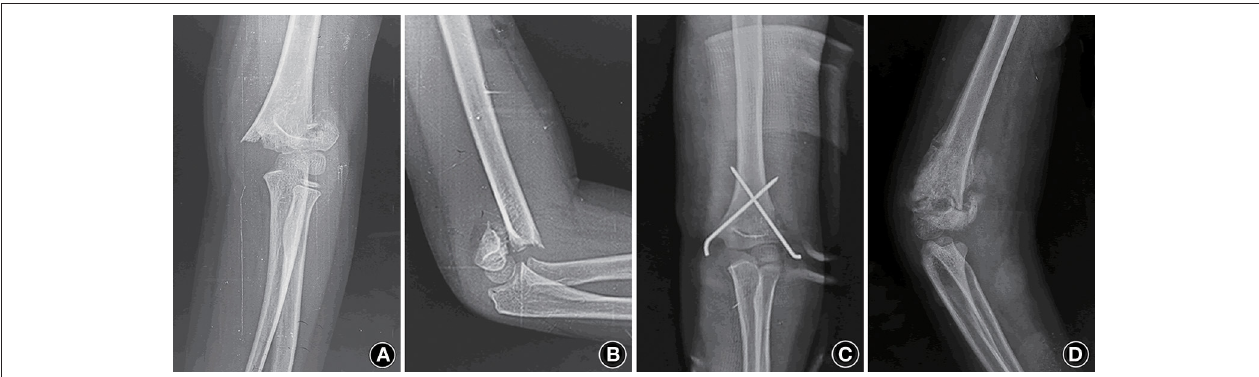
FIGURE 1 | (A,B) Anteroposterior and lateral view of the left elbow present a supracondylar fracture of the humerus (Gartland type III). (C) Anteroposterior radiograph after the first surgery shows the fracture reduced with cross pinning. (D) Radiograph of the left elbow show some calcificated tissue around the elbow 3 months after the first